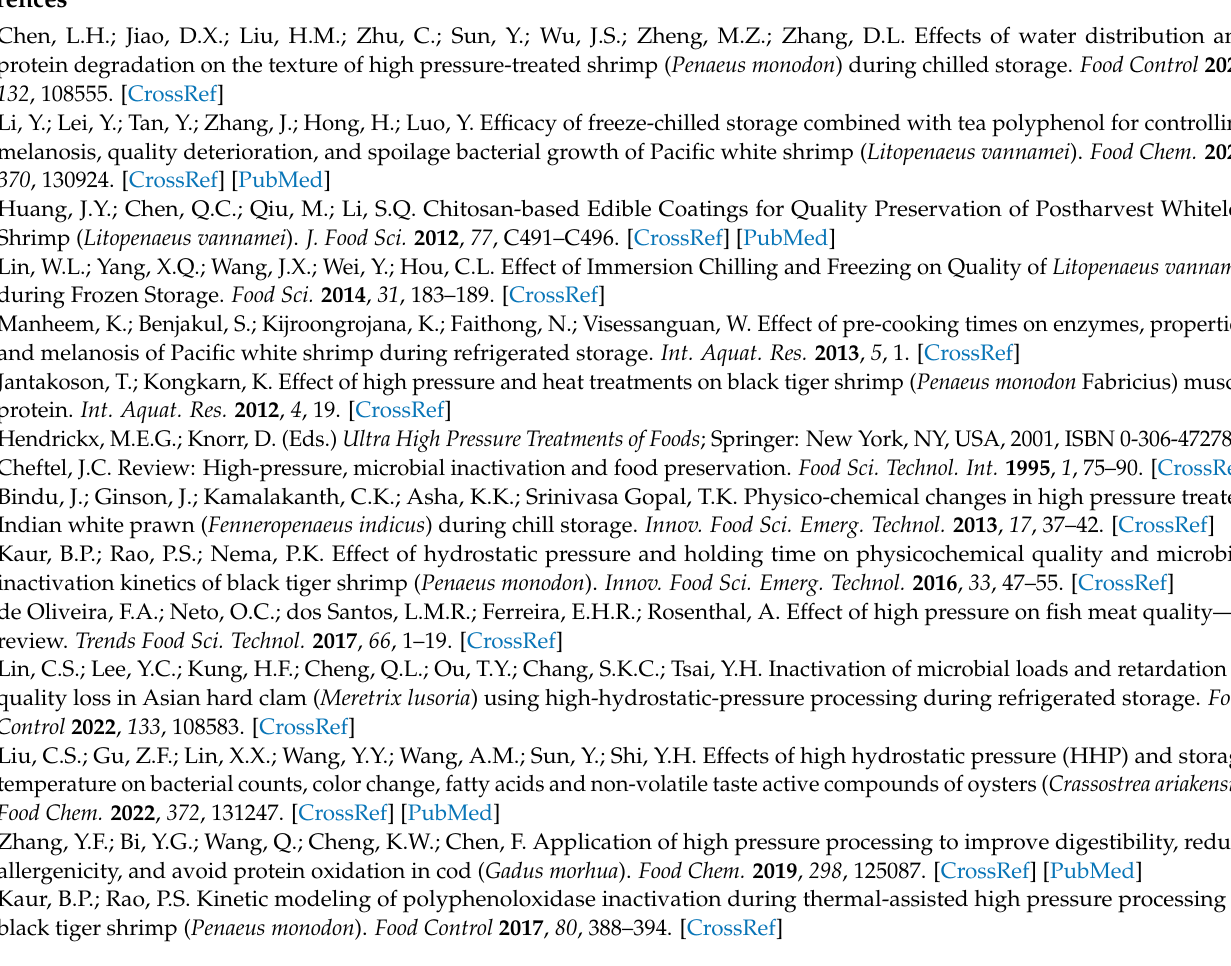
pressure. Table S2: The corresponding substrates, reaction buffers, and stopping solution of cathepsin B, H, and L. Table S3: Effects of UHP treatment on textural properties of shrimp during iced storage. Figure S1: The standard curve of